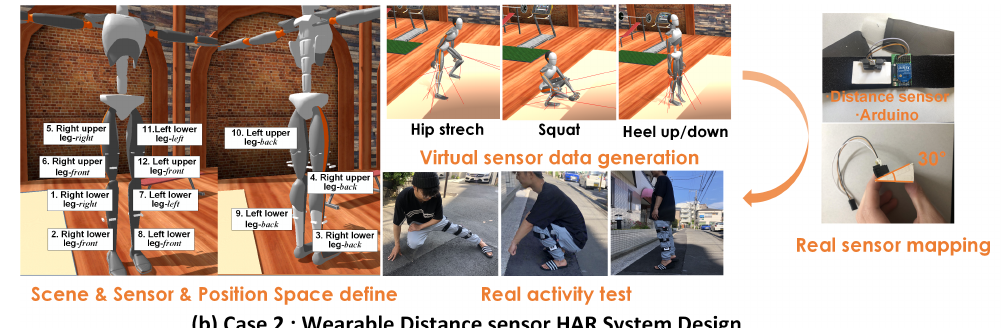
Figure 9. Case 2: Wearable distance sensor study; 12 sensor position spaces on the lower body are defined, 3 exercises are recognized.